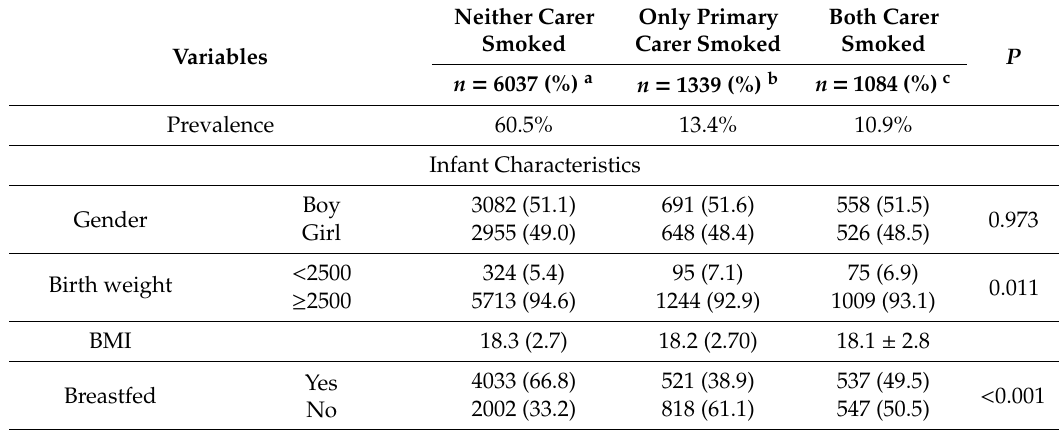
Table 1. Baseline distribution of infant, carers’ and household characteristics according to carers’ smoking status at